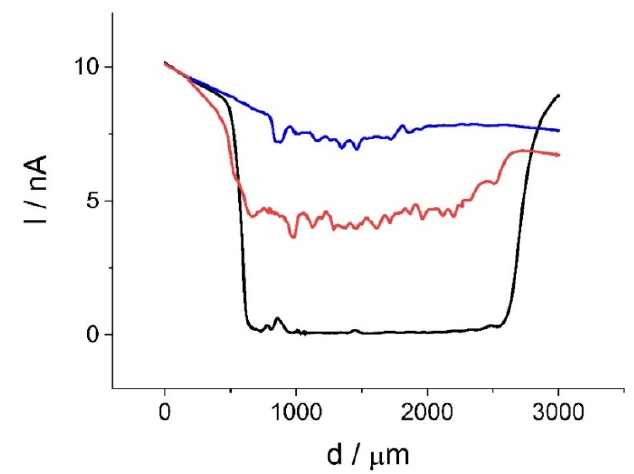
Figure 11. One-dimensional scans recoded recorded in 2 mM rac-(±) FcEA acetonitrile solution, with a Pt microdisk 12.5 µm radius, biased at 0.55 V, above the oligo( S )-BT 2 T 4 -Au: Unbiased (blue line), biased at 0.45 V (red line) and at 1 V (black line). Tip to substrate distance 10 µm.